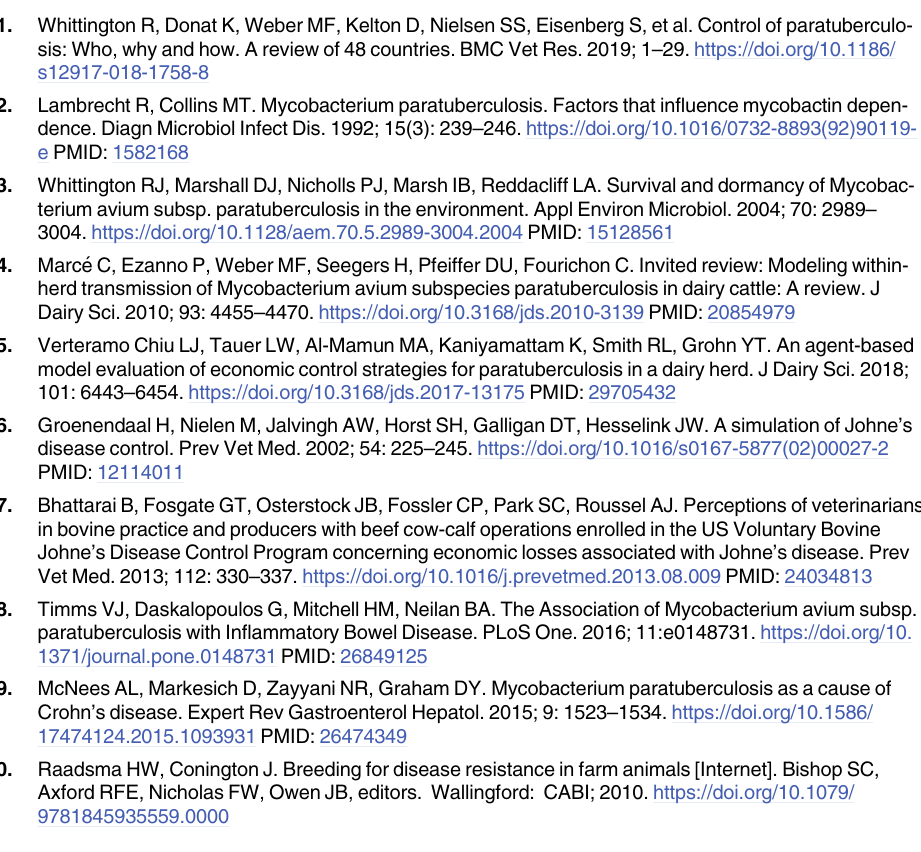
S1 Table. Primer and probes, used for genotyping of EDN2 rs109651404 , rs110287192